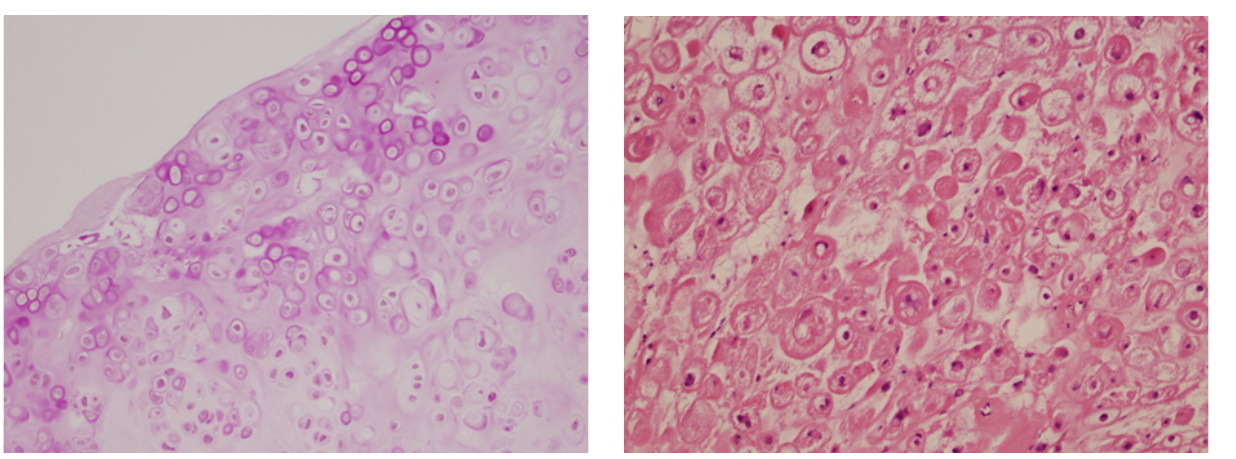
Fig. 4. Skeletal conventional chondrosarcoma also contained chondrocytes with thick APAS positive rings at the periphery of some neoplastic lobules, x50.